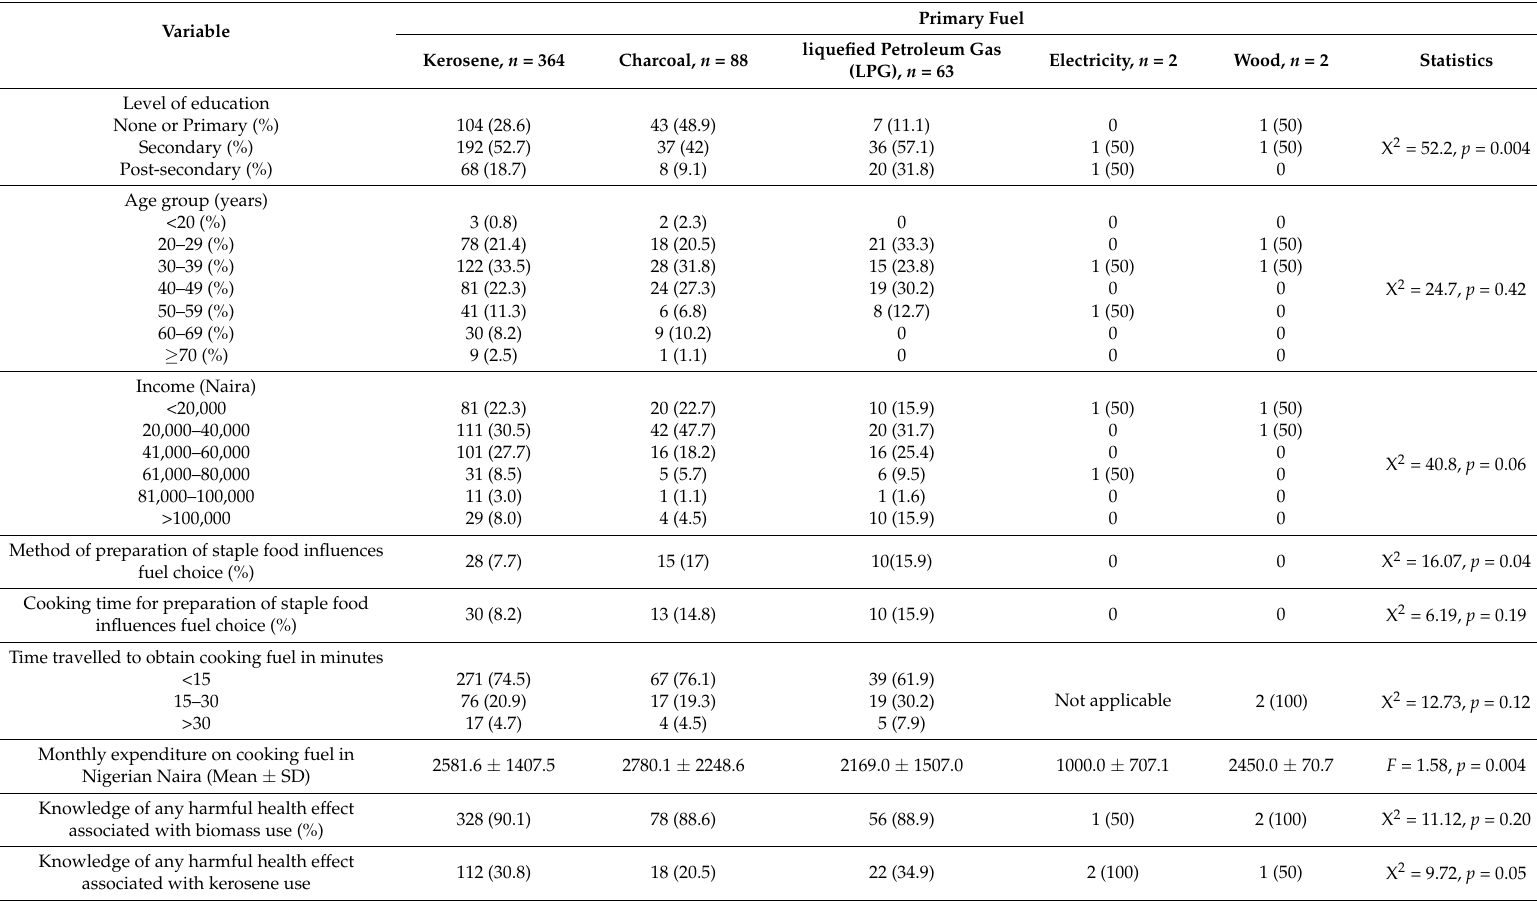
Table 5. Association between fuel types and selected